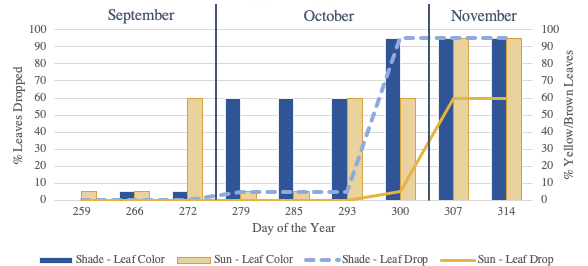
Figure 6. Temporal changes in leaf color change (bars) and leaf drop (lines) recorded in fall 2016 in the aspen trees growing in shaded (blue) and sunny (yellow) areas. On DOY 272, the team noted that 65% of the leaves in the aspen tree receiving more sunlight changed color, but on subsequent Figure 4. Total monthly precipitation recorded for September, observations (DOY 279 and 285) recorded that there was 5% October, and November 2015 – 2018, along with the historical color change. Hence the observation recorded for the sunny tree averages for each month. on DOY 272 was excluded from interpretation. Leaves of